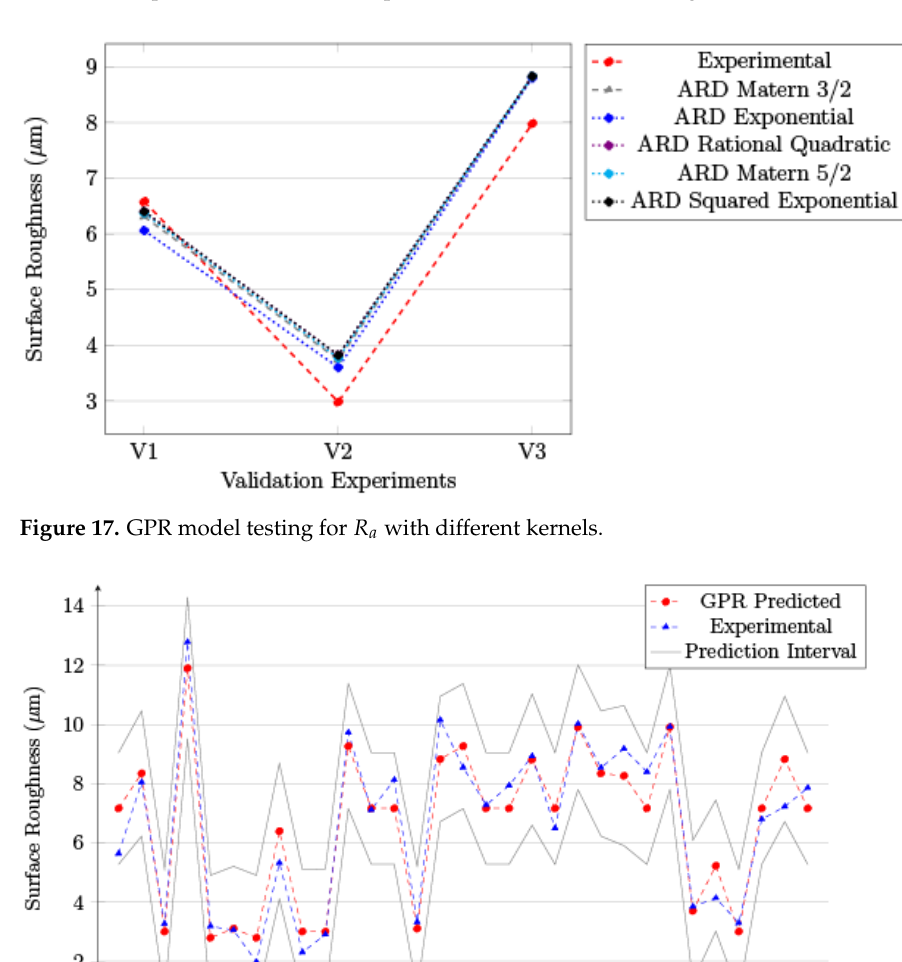
Figure 16. Experimental and GRNN predicted values for Ra training data.